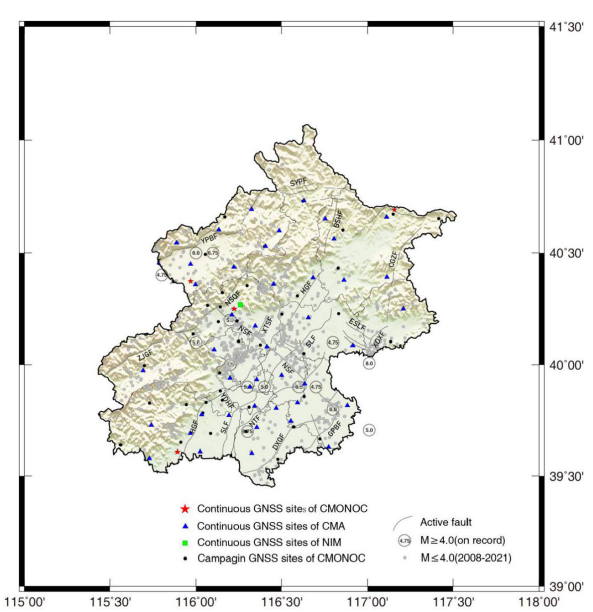
Figure 1. Tectonic setting and locations of GNSS sites of Beijing area.